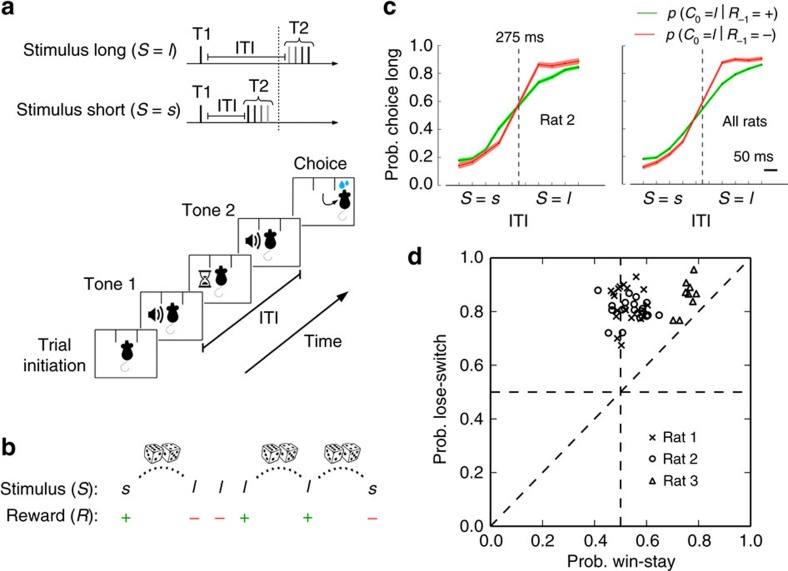
Rats use the trial-by-trial-dependent contingencies of the task to improve their performance.(a) Schematic of the task (see Methods for details). Two identical, consecutive tones (T1 and T2) are presented to the rats (top panel). Inter-tone intervals (ITIs) can belong to two stimulus categories: short, S=s, or long, S=l. Each category has four possible ITIs (short: 50, 100, 150 and 200 ms; long: 350, 400, 450, 500 ms). The vertical dotted line represents the decision boundary at 275 ms. Difficult ITIs, depicted in gray, lie close to the decision boundary. Sequence of events within a trial (bottom panel): from trial initiation to choice. Rats self-initiate the trial and sample the stimuli in the central socket. They are rewarded with water if they poke the right socket when the stimulus is long, and the left socket when the stimulus is short (for rat 3 the contingency was the opposite). (b) The sequence of trials follows an outcome-coupled hidden Markov chain (see also Supplementary Fig. 1): a new random stimulus condition is presented after a correct response (+), while the same stimulus condition is presented after an incorrect response (−). (c) Psychometric curves (probability choice long versus ITI) after correct responses (green line) and after incorrect responses (red line) for an example rat (left panel) and for all rats (right). The slope of the psychometric curves after incorrect responses substantially and significantly increases relative to the slope of the curve after a correct response. Error bars (shaded) are estimated by bootstrap (one s.d.). (d) Probability of lose-switch versus probability of win-stay. Each point corresponds to a different session. Rats predominantly follow a lose-switch over a win-stay strategy. No strategy being followed corresponds to the point (0.5, 0.5) in the plot.